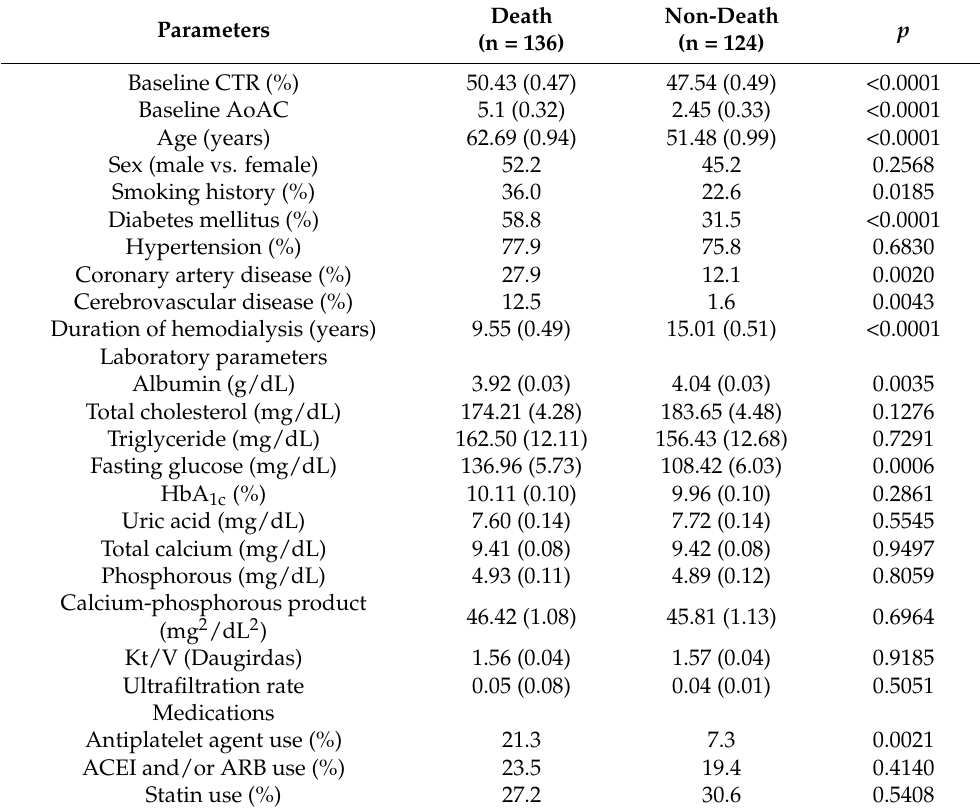
Table 4. Comparison of baseline characteristics between patients with or without